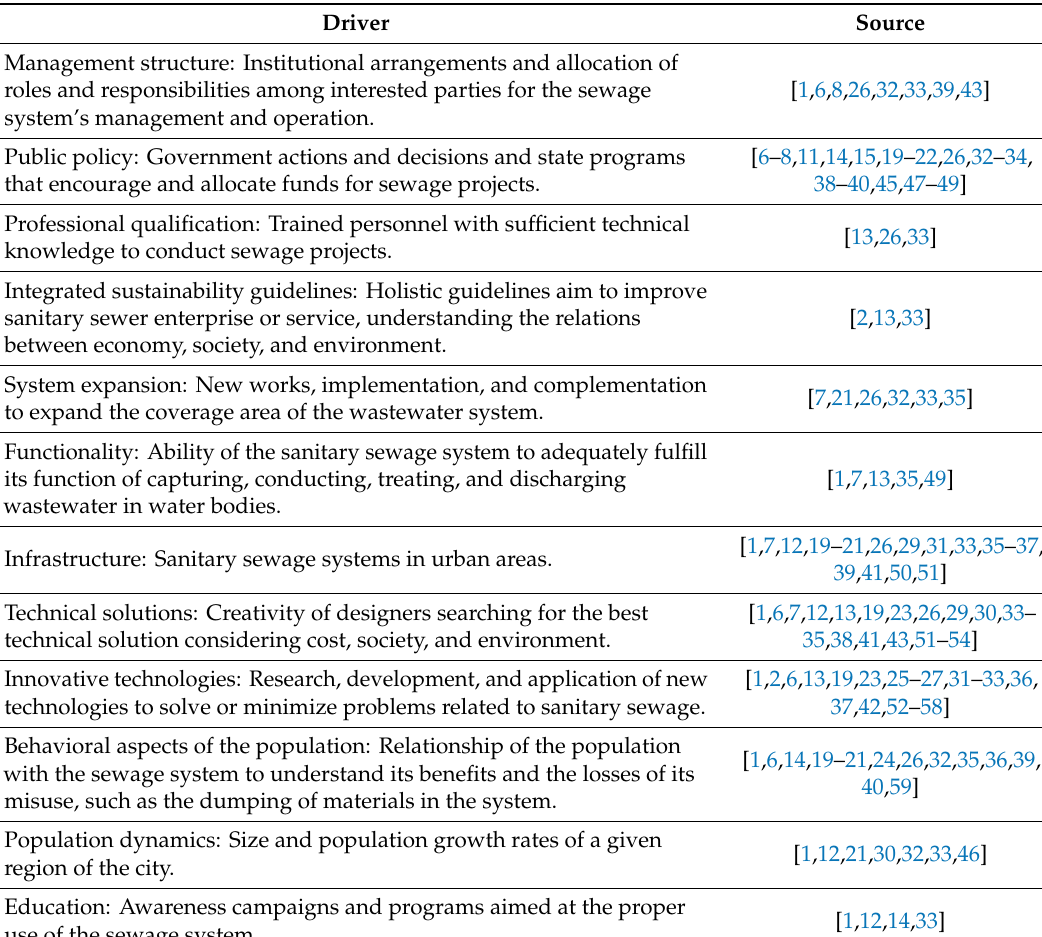
Table 1. Cont. Driver Source